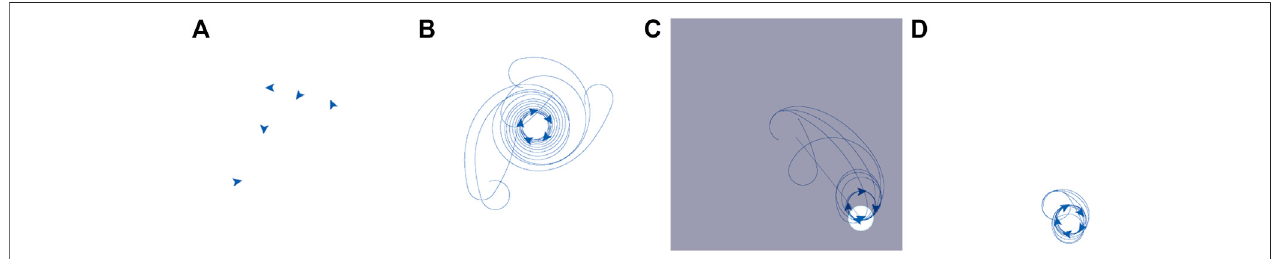
FIGURE 7 | Our algorithm implemented with NetLogo. Five agents are initially dispersed at random on the plane (A) . The agents gather to a rotating regular pentagon (B) .Draggingoneoftheagentstothebottomleftcornerofthearena,therestoftheagentsfollowandultimatelyformarotatingsquareaboutthe “ draggedleader ” (C) . “ Releasing ” the leader, it returns to the swarm, and again a rotating pentagon forms, at the new location (D)